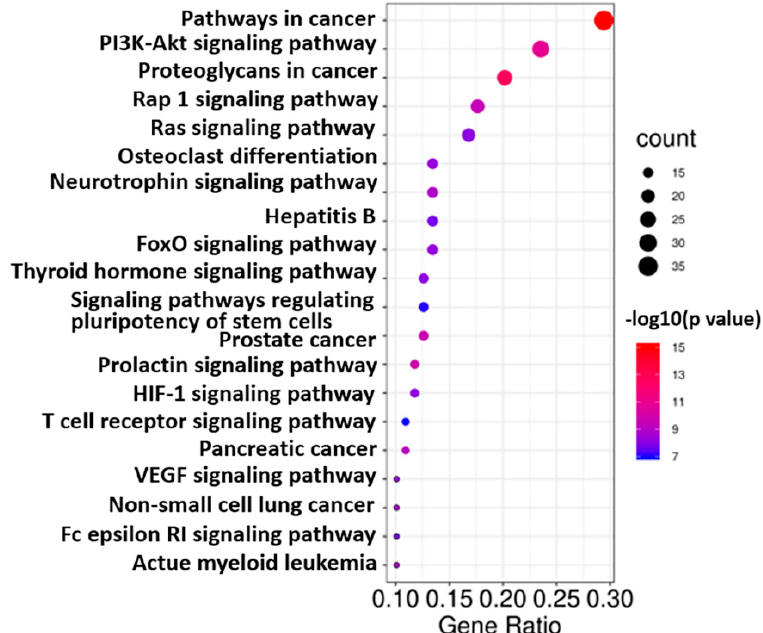
Figure 7. Top 20 pathways enriched through KEGG analysis for co-targets of GCK–osteoporosis.